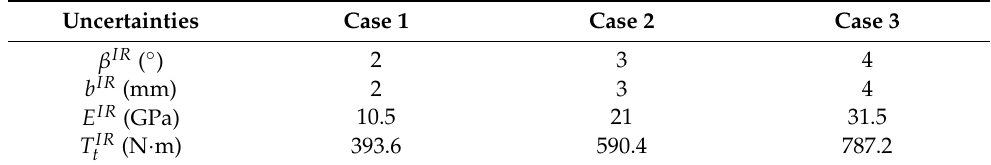
Table 3. Three uncertainty